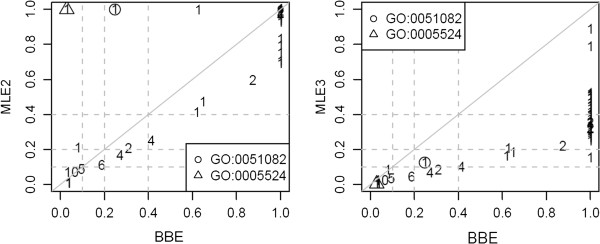
Comparison of the LFDR estimated by BBE with the LFDR estimated by MLE2 (left) and MLE3 (right). Each integer represents a number of GO terms. Intergers > 1 indicate ties.